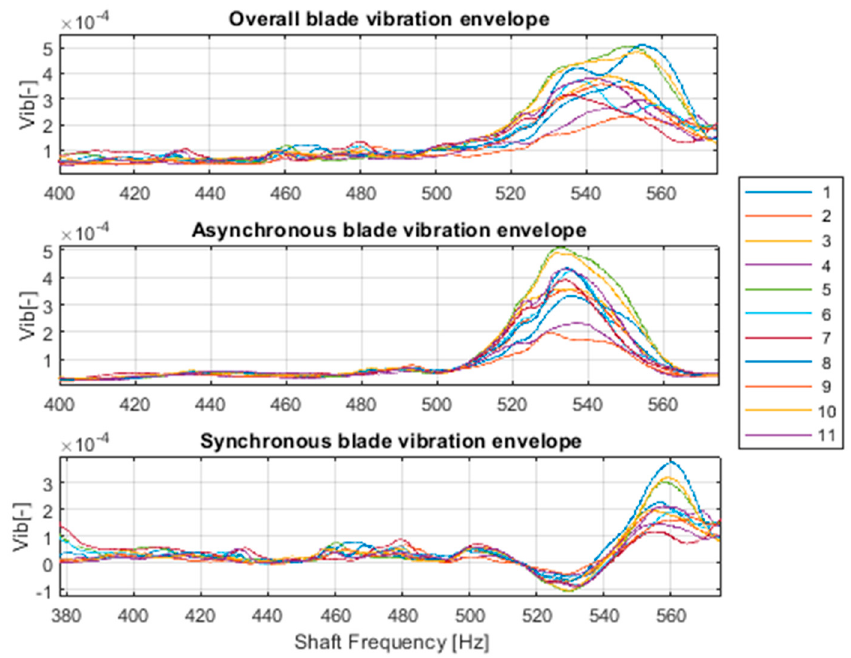
Figure 10. Synchronous and asynchronous vibration amplitude (adimensional) as a function of the rotational frequency of the shaft for all the 11 blades.